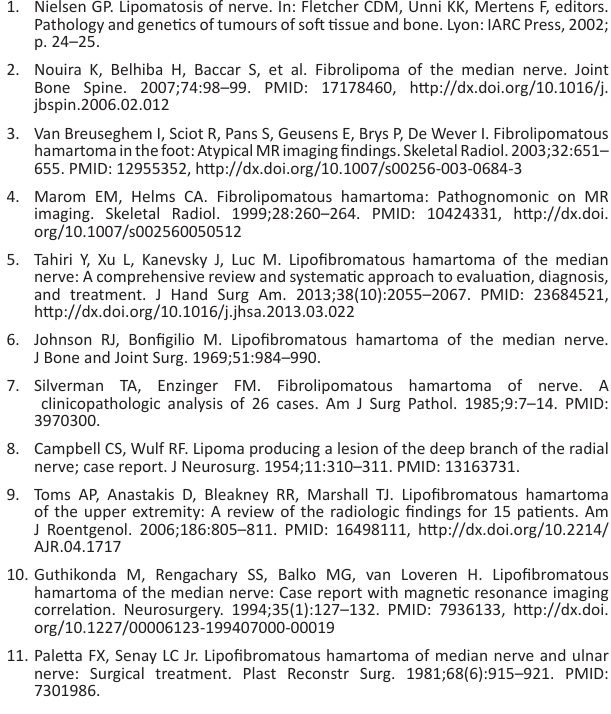
FIGURE 5: T1WI axial MR image demonstrates enlargement of the slightly hyperintense median nerve fascicles with a characteristic ‘ coaxial cable-like’ appearance (white